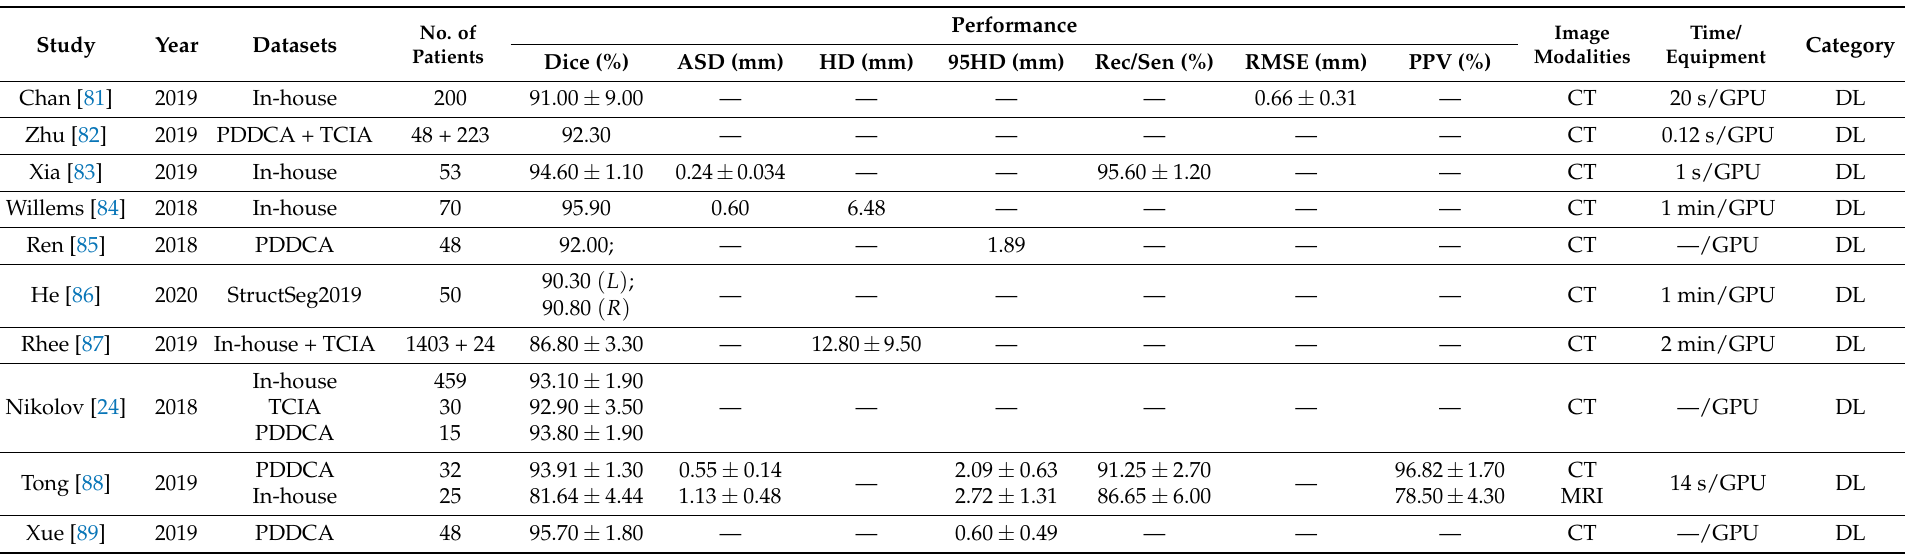
Table 8. Summary of 3D network strategies of deep learning-based methods.